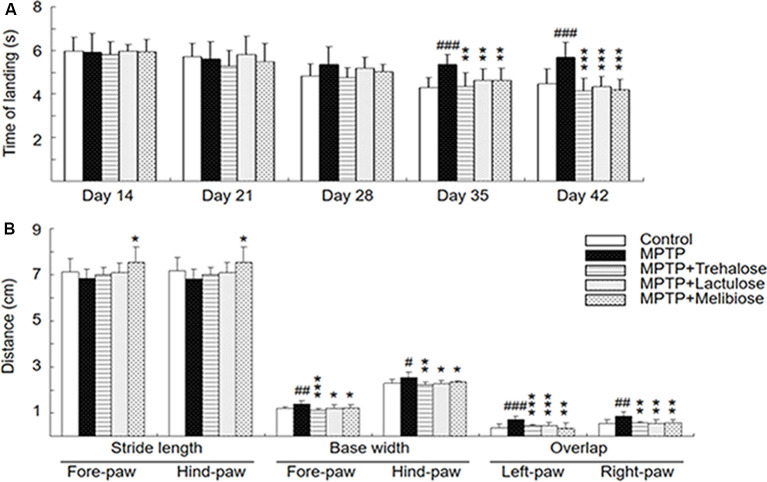
Neuroprotective effects of trehalose and analogs in the MPTP-induced Parkinson’s disease (PD) mouse model. (A) Pole test was conducted at days 14, 21, 28, 35 and 42. The time for mice to turn completely downward and land on the floor was recorded (n = 8). (B) Gait test was conducted at day 42. Stride length (fore-paw and hind-paw), base width (fore-paw and hind-paw) and overlap (left-paw and right-paw) were measured manually as the distance between two paw prints (n = 8). P-values, ANOVA with LSD post hoc test, MPTP vs. control (#P < 0.05, ##P < 0.01 and ###P < 0.001) and disaccharide-treated vs. untreated (*P < 0.05, **P < 0.01 and ***P < 0.001).